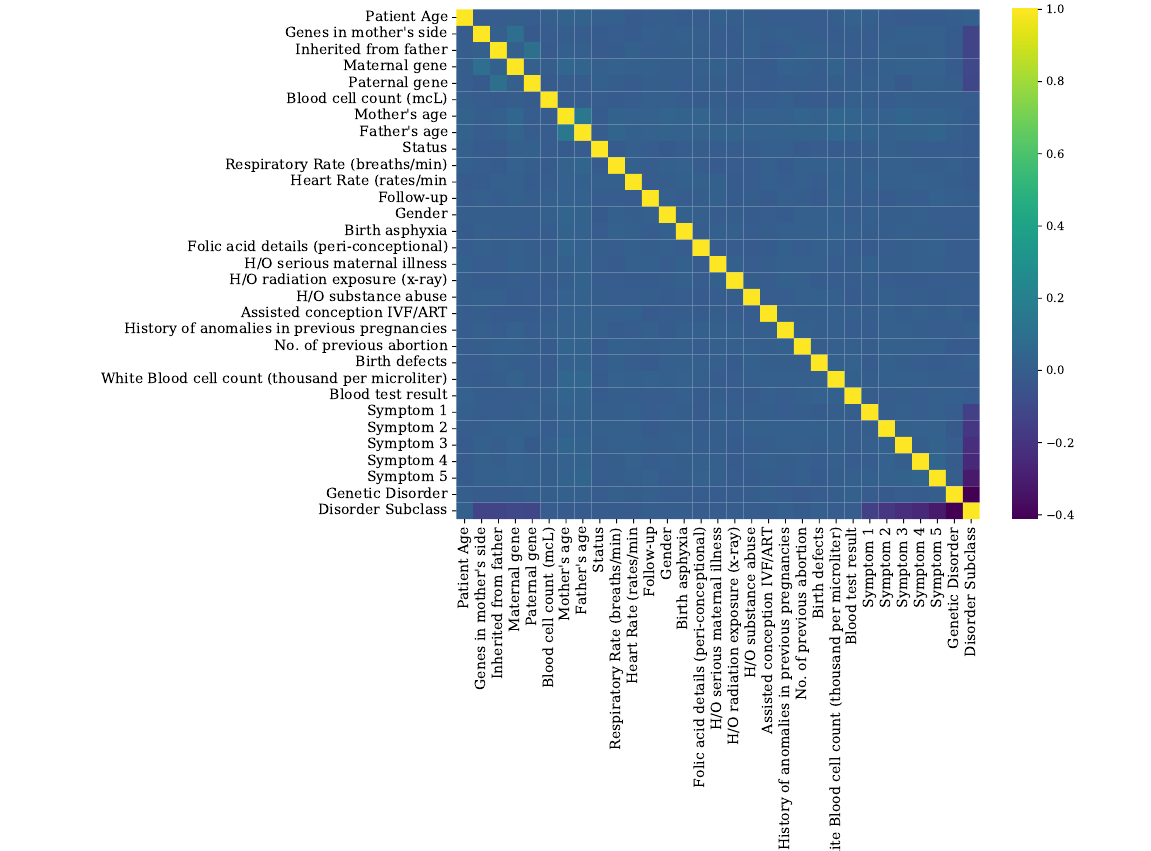
Figure 6. Age analysis of patients for the disorder category.